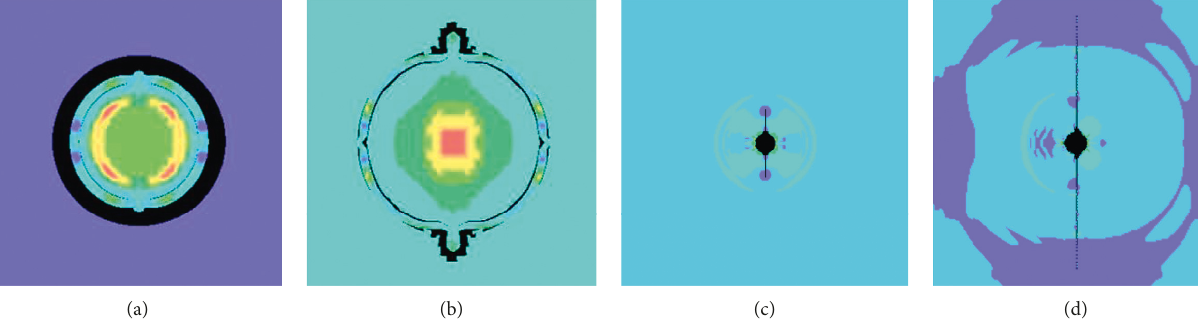
Figure 4: The initiation and propagation of the directional crack in the sandstone: (a) t � 1.89; (b) t � 6; (c) t � 60; (d) t � 300.